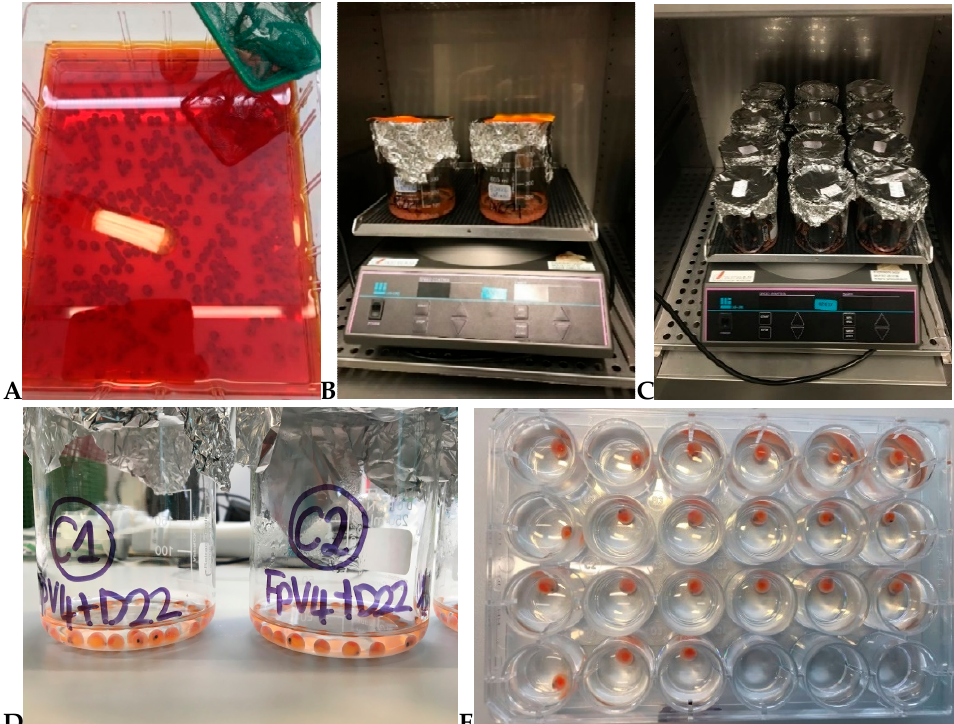
Figure 1. Illustrated overview of the experimental procedure followed in the various experiments concerning F. psychrophilum and its phages. ( A ) Disinfection of eyed eggs following standard procedures used in hatchery facilities (iodine-based solution) performed at the start of each experiment; ( B ) eyed eggs during the two-hour bacterial bath challenge with F. psychrophilum and incubation at 10 °C (experiments section A and C); ( C ) eyed eggs during the phage bath and incubation at 10 °C (experiments section B and C); ( D ) eyed eggs for phage bath placed in 250 mL sterile glass beakers (experiments section B and C); ( E ) eyed eggs during incubation in 24-well plates (experiments section A, B, and C) (photos by V.L. Donati).